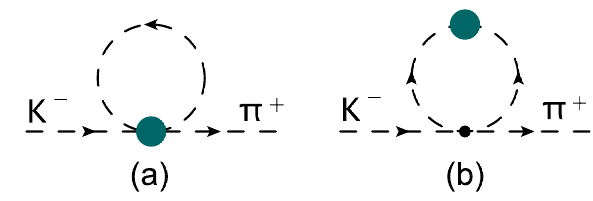
Figure 3 . Feynman diagrams for one-loop corrections to the K (cid:0) ! (cid:25) + transition amplitude due to one insertion of hadronic operators (in blob) shown in table 3. The small dot stands for a (cid:31) PT vertex at O ( p 2